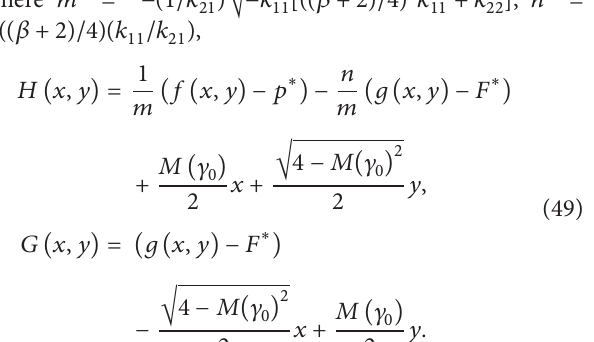
Figure 3: 𝑢 11 = 1 , 𝑢 12 = 0.5 , 𝑢 22 = 0 , 𝜉 = 0.85 , and 𝛽 = 0.4 . As 𝛾 is sufficiently large, there are stable 3-periodic points (at 𝛾 ≃ 56.5 ), and then stable 6-periodic points occur at 𝛾 ≃ 67.5 . And stable 3- periodic points occur at 𝛾 ≃ 201 again.